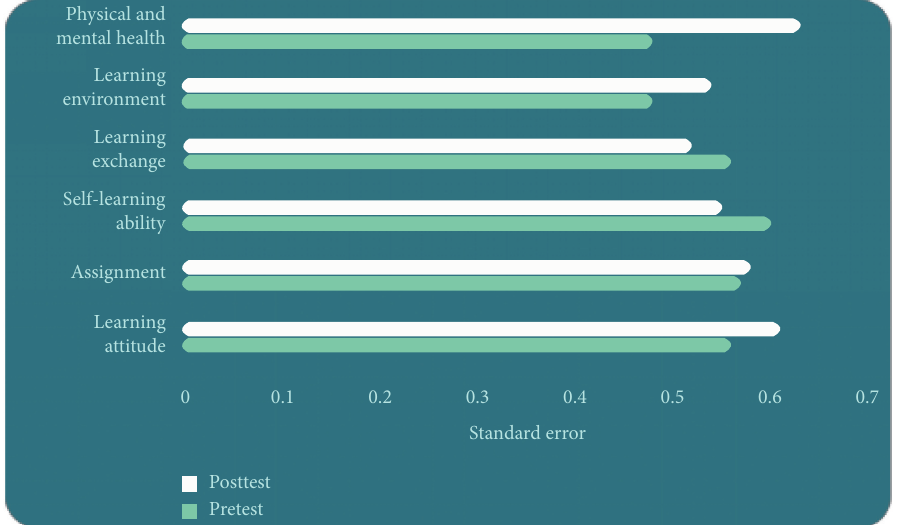
Figure 4: Changes in the standard deviation of students’ learning adaptability based on the computer engineering education